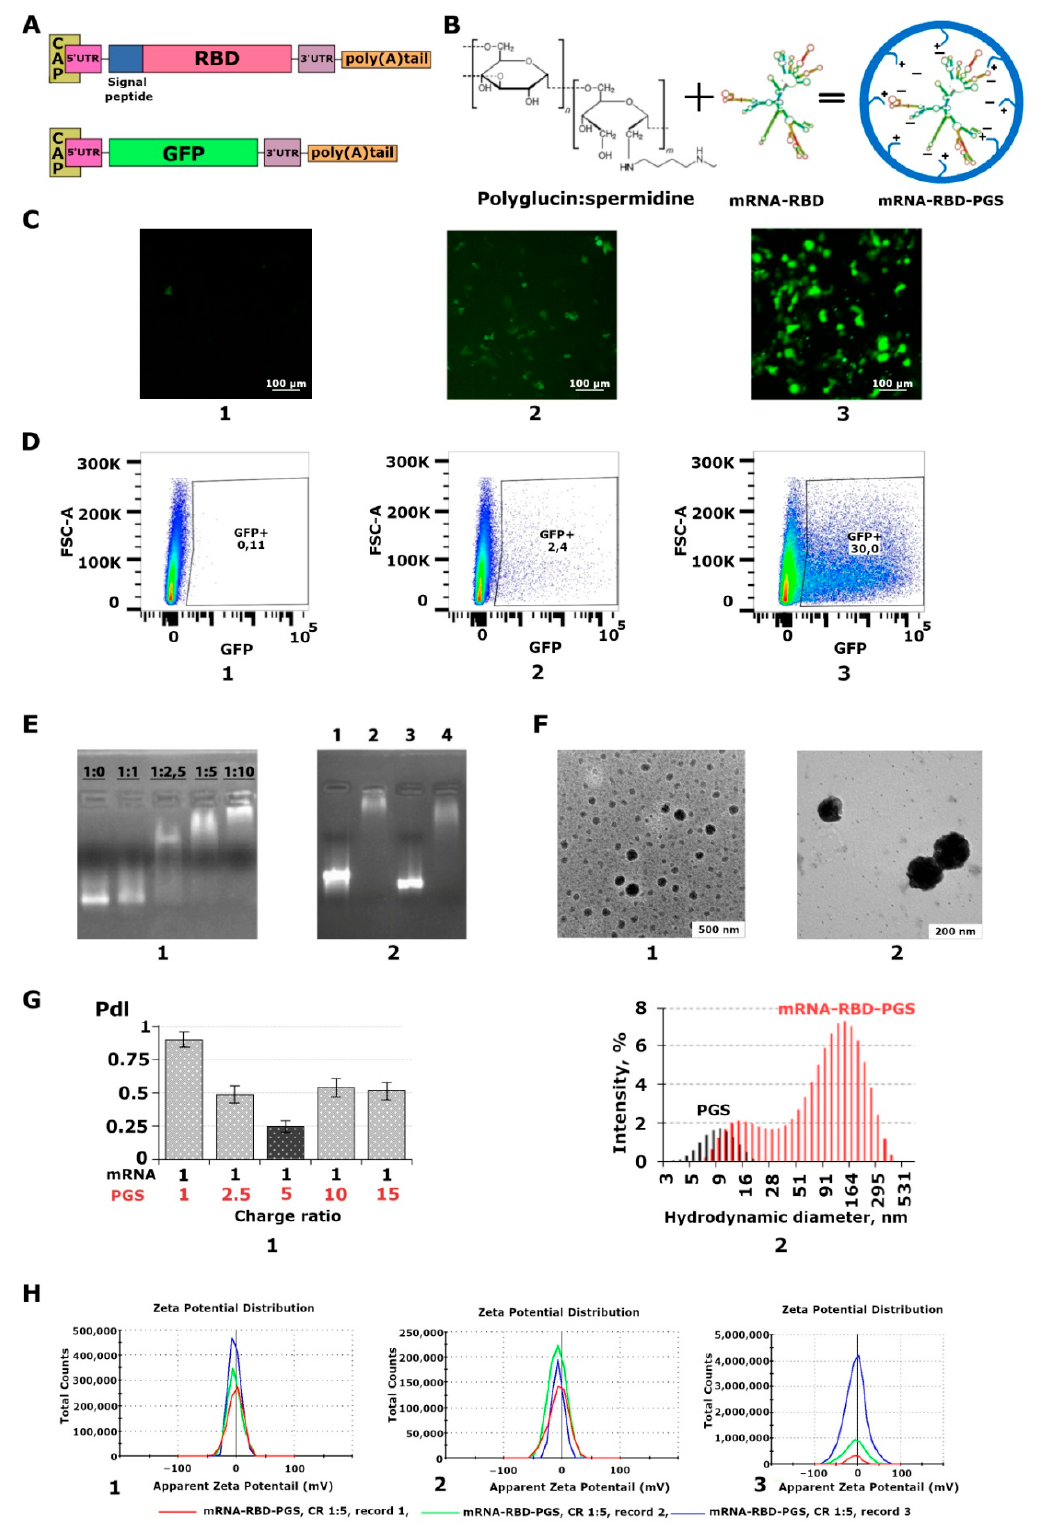
Figure 1. Preparation and characterization of mRNA and polyglucin:spermidine conjugate (PGS) complexes. ( A ) Schematic representation of mRNA-RBD, and mRNA-GFP. mRNA has a cap, poly ( A ) tail, 3’ and 5’ UTRs, and ORF encoding receptor binding domain (RBD) or green fluorescent protein (GFP). mRNA-RBD additionally contains a signal peptide to increase the secretion of the synthesized protein. ( B ) Self-assembly of mRNA-RBD-PGS or mRNA-GFP-PGS complexes. The chemical formula of the polyglucin:spermidine conjugate and the hypothetical structure of mRNA and mRNA-PGS complexes is presented. ( C ) Transfection of HEK293T cell culture with: (1) mRNA-GFP, (2) mRNA-GFP-PGS, and (3) mRNA-GFP-Lipofectamine 3000. Results were visualized with an Olympus CKX53 microscope 24 h after transfection.